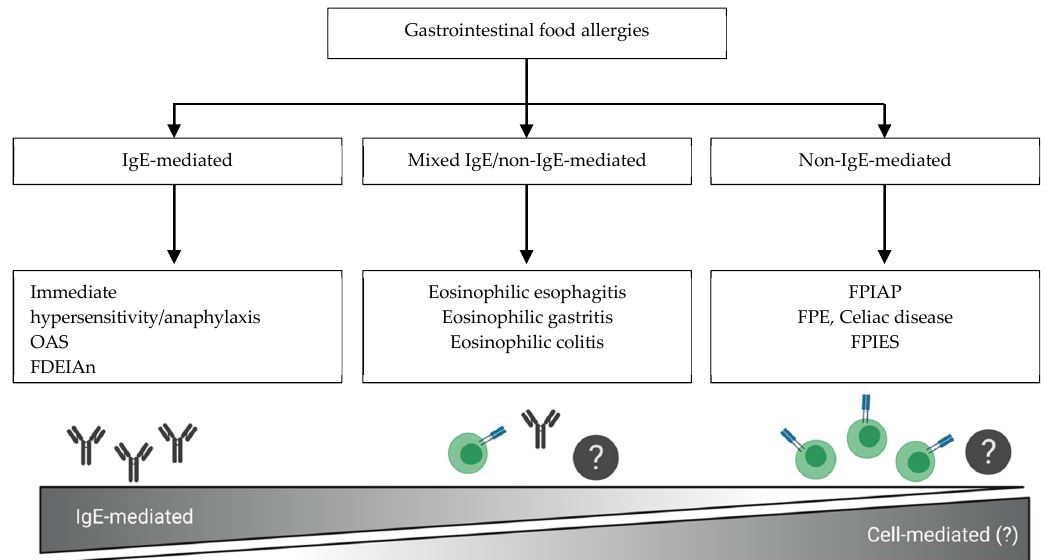
Figure 1. Classification of gastrointestinal food allergies. FDEIAn, food-dependent exercise-induced anaphylaxis; FPE, food protein-induced enteropathy; FPIAP, food protein-induced allergic proctocolitis; FPIES, protein-induced enterocolitis syndrome; IgE, immunoglobulin E; OAS, oral allergy syndrome.